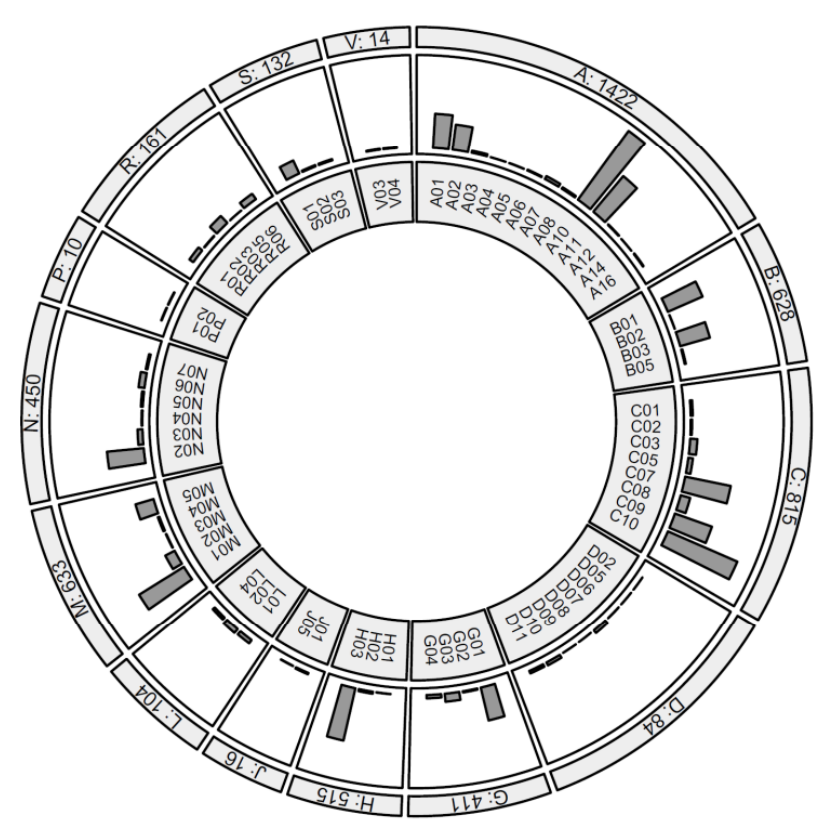
Figure 2. Counts of drugs taken by 6000 QBB participants, ordered by ATC therapeutic subgroup.